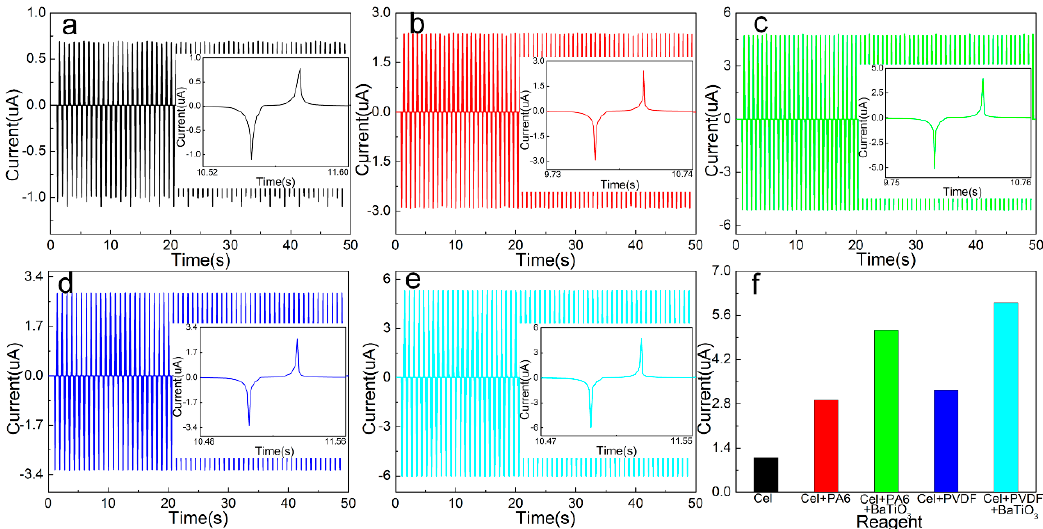
Figure 6. Output current of a single different type of friction layer: ( a ) Cel, ( b ) Cel + PA6, ( c ) Cel + PA6 + BaTiO 3 , ( d ) Cel + PVDF, ( e ) Cel + PVDF + BaTiO 3 , ( f ) maximum instantaneous value.